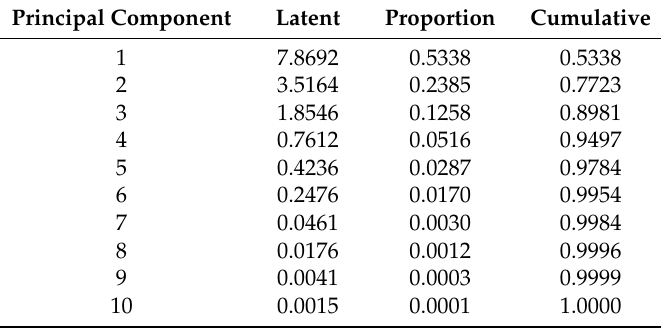
Table 3. Latent, proportion, and cumulative values of selected principal components for relative voltage value feature in the PEN3